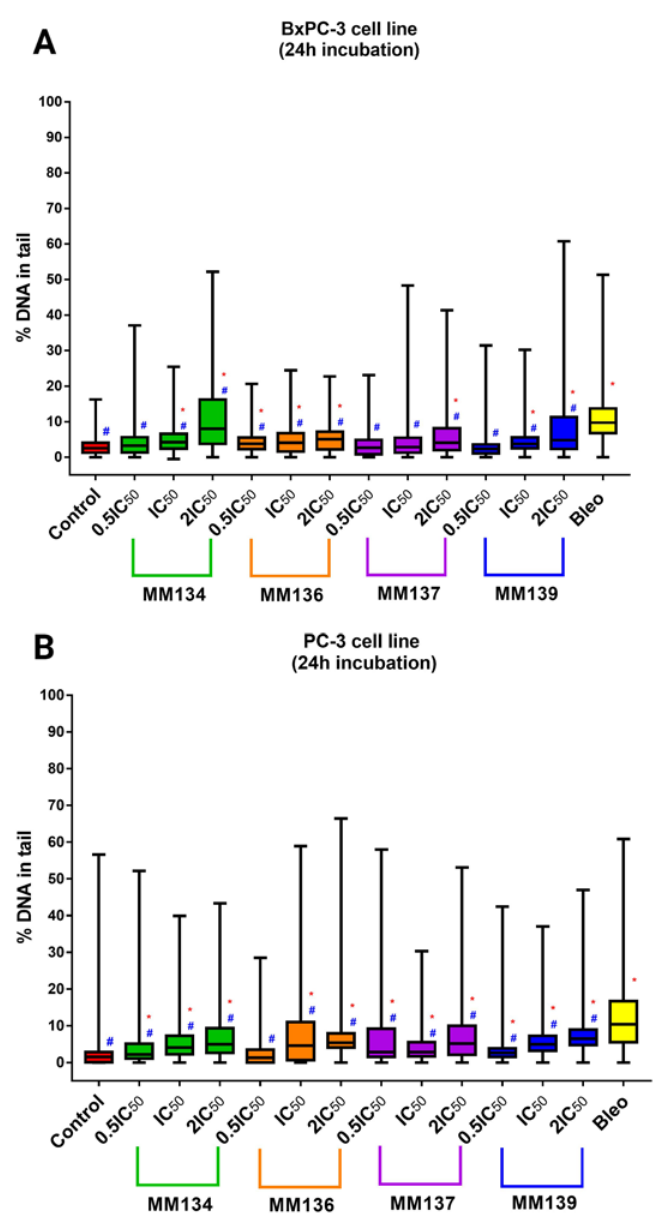
Figure 8. DNA damage in cancer cells estimated with 24 h neutral comet assay: determination of DNA damage (double-strand breaks) induced by 0.5 × IC 50 , IC 50 , and 2 × IC 50 concentrations of MM134 , -6 , -7 , and -9 in cancer cell lines (BxPC-3 ( A ), PC-3 ( B )) after 24 h incubation of cells with tested compounds. Data are represented as median tail DNA % with interquartile range and minimal and maximal values. The Kruskal–Wallis test was used to show a statistically significant difference between groups. Multiple comparisons using mean ranks for all groups module of Statistica software were used. In all groups, N > 200. * significant difference compared to the negative control; p < 0.05. # significant difference compared to the positive control (20 µM bleomycin); p < 0.05. The tested compounds used in concentrations followed by IC 50 values (0.5 × IC 50 , IC 50, and 2 × IC 50 ) induced a dose-dependent and statistically significant increase in DNA dam- age compared with the negative and positive control ( p < 0.05) in 2 × IC 50 concentrations for both BxPC-3 and PC-3 cells following 24 h incubation time. A statistically significant increase in DNA damage compared to negative and positive control was also observed for cells incubated with IC 50 concentrations of MM134 , -6 , and -9 in the BxPC-3 cell line